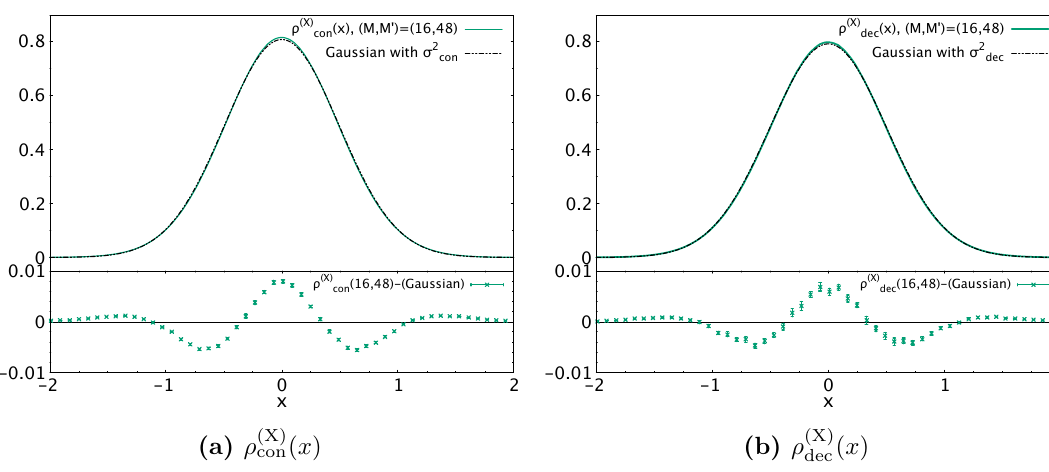
Figure 23. Comparison between ρ (X) con ( x ) and ρ (X) Gaussian distributions. The histograms of ρ (X) con ( x ) and ρ (X) namely N = 64 , L = 24 , and T = 0 . 885 . The variances of the Gaussian are chosen as σ 2 and σ 2 = 0 . 254 dec